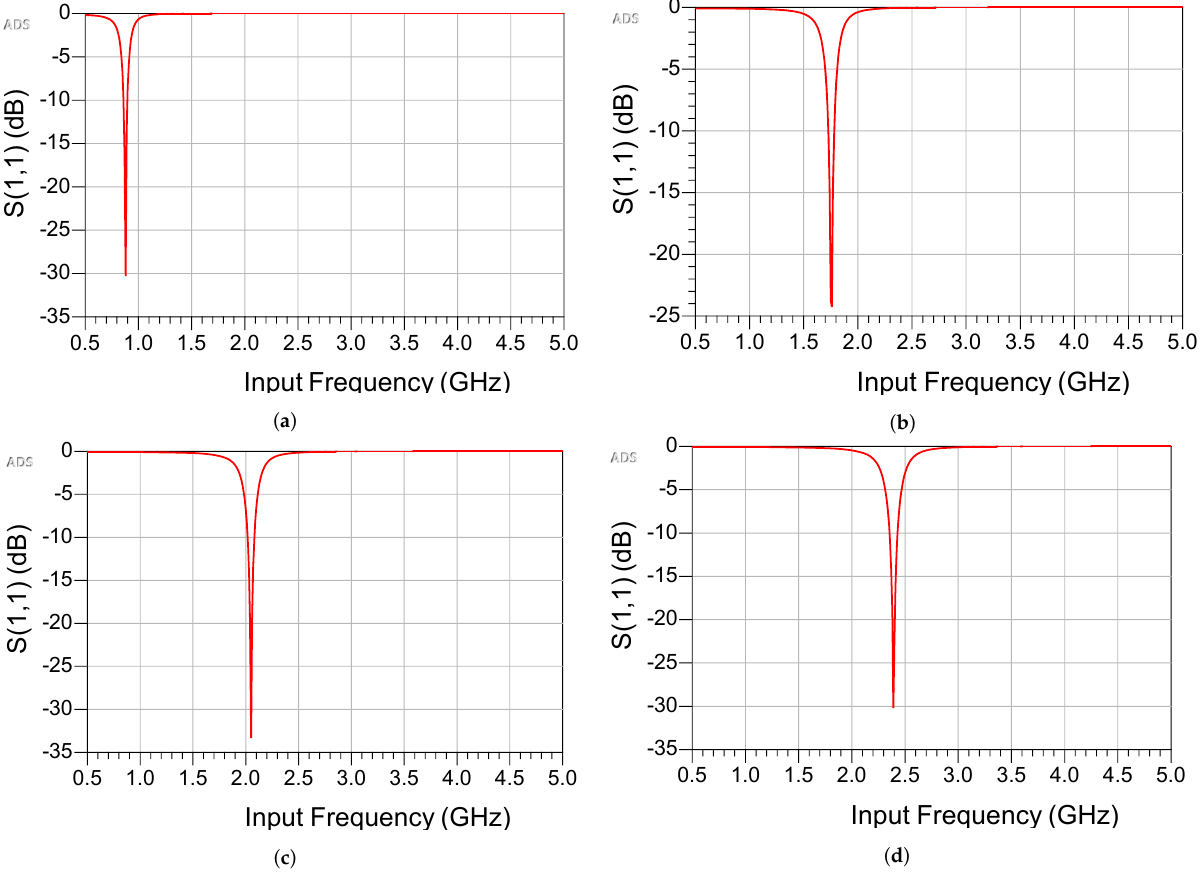
Figure 15. S-parameters of the proposed quad-band circuit with four receiving antennas. ( a ) GSM-900. ( b ) GSM-1800. ( c ) UMTS-2100. ( d ) Wi-Fi 2.45.